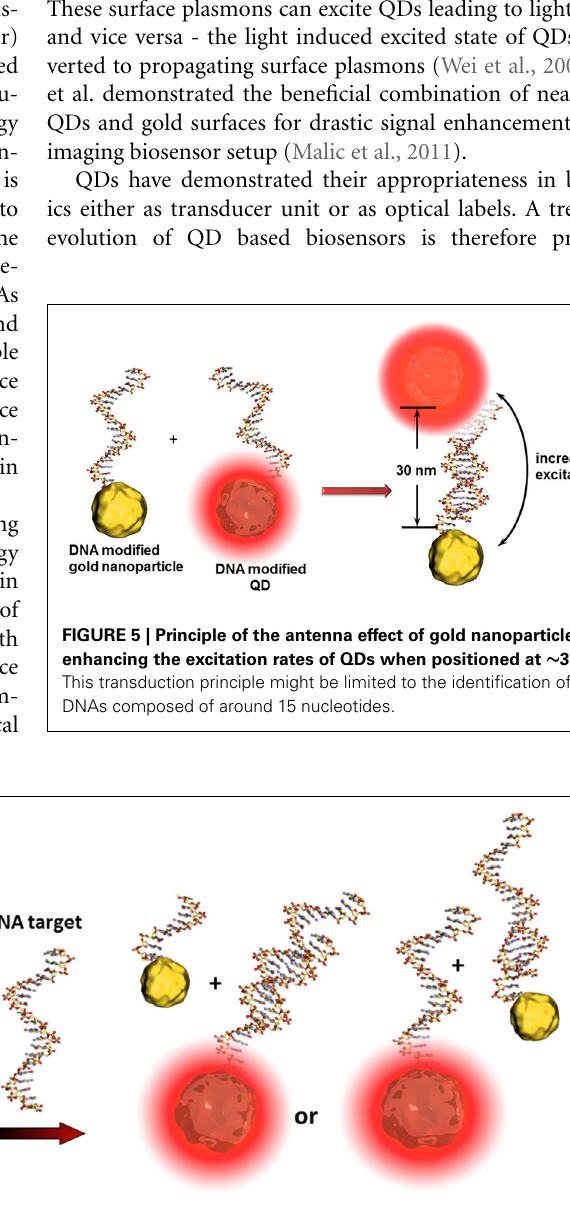
DNA, the short sequence of the gold nanoparticle label, or with both. These statistical hybridization events have to be considered for the quantification of the